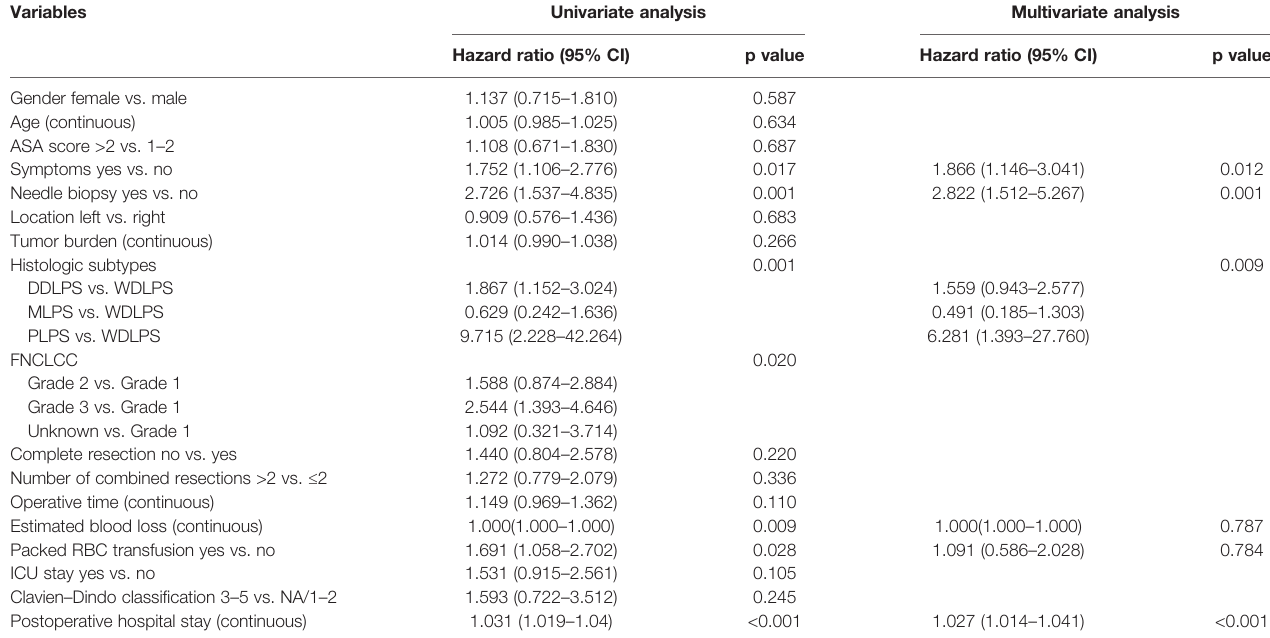
TABLE 4 | Univariable and multivariable analyses to determine independent predictors of progression-free survival of primary retroperitoneal liposarcoma. Variables Univariate analysis Multivariate analysis Hazard ratio (95% CI) p value Hazard ratio (95% CI) p value Gender female vs.